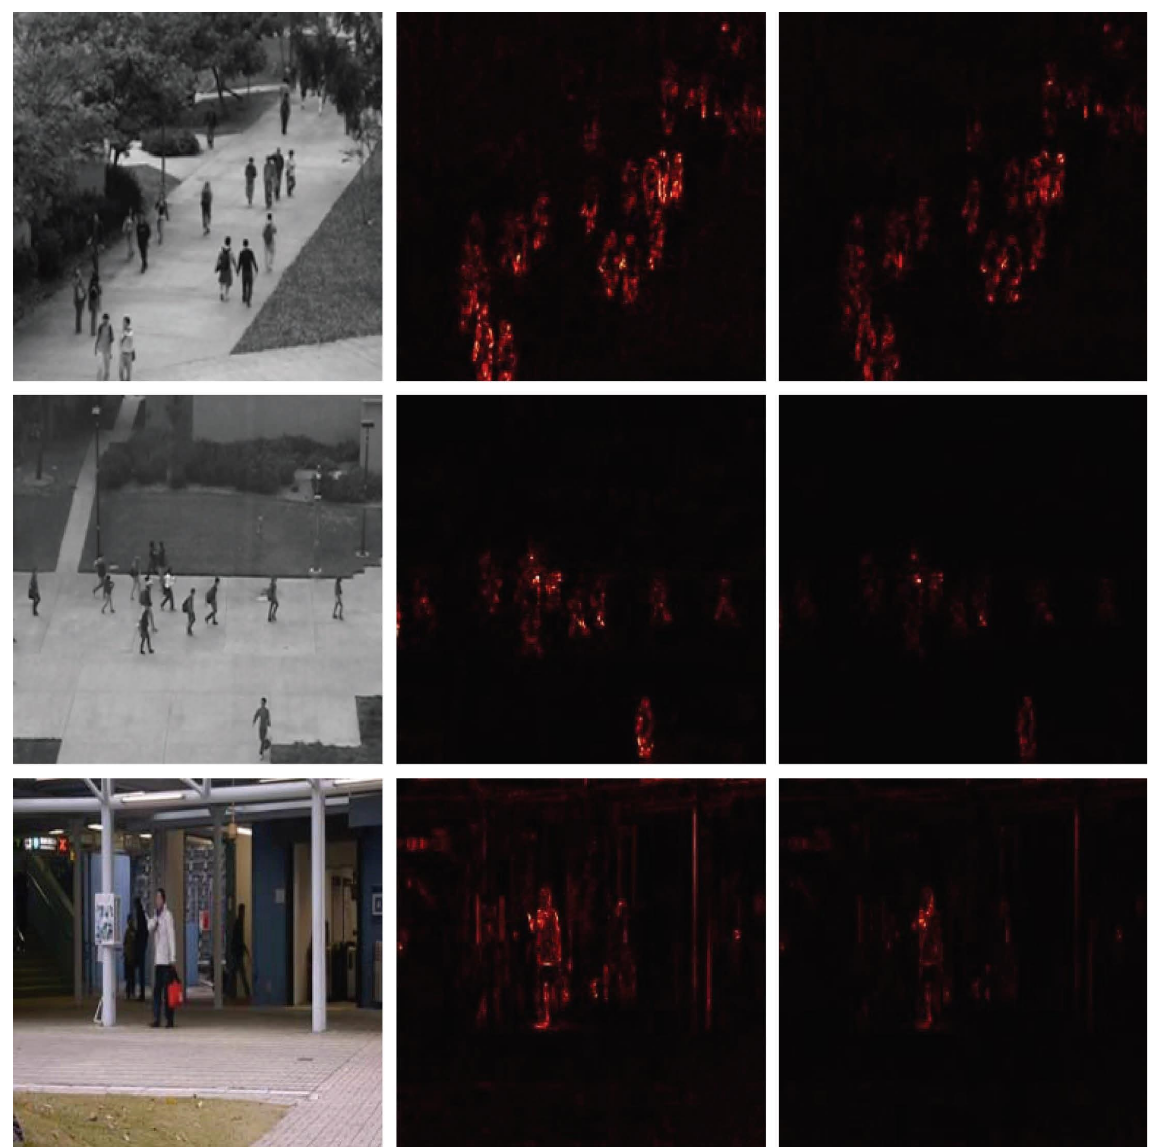
Figure 10: Refactoring error of normal behavior